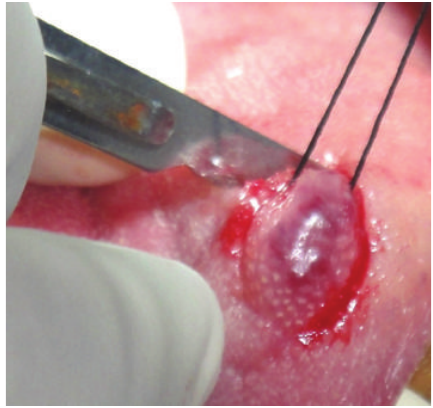
Figure 3: Surgical excision.